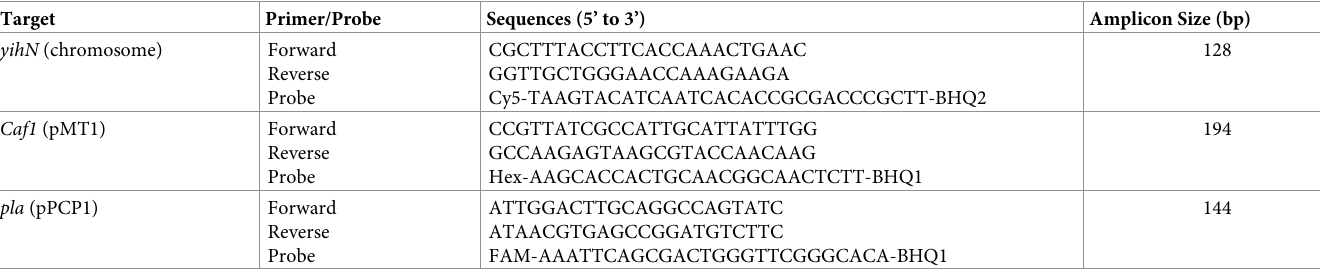
Table 1. Primers and probes were used to detect Y . pestis